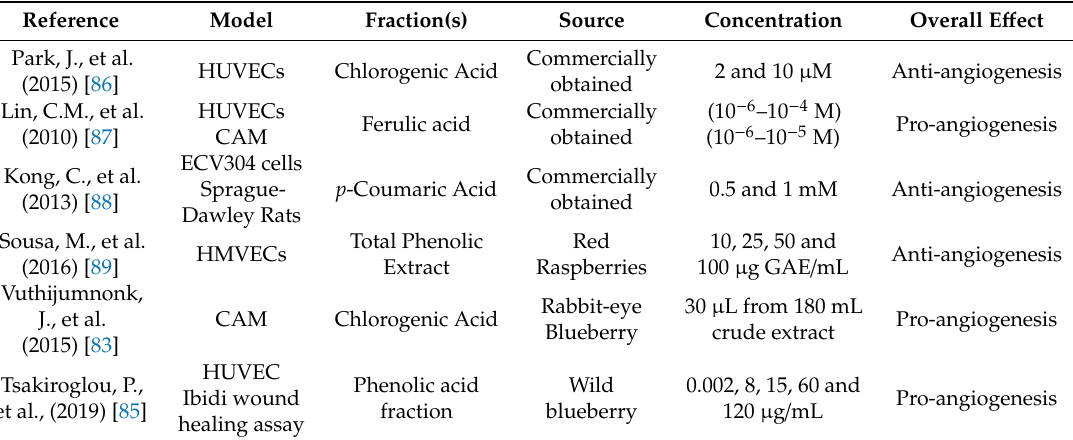
Table 2. Role of phenolic acids on cell migration and